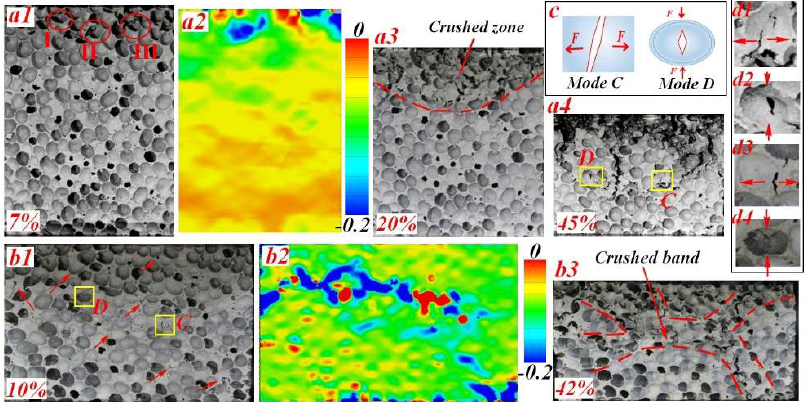
Figure 9. Typical deformation behavior of FG foam under ( a ) LC and ( b ) TC, ( c ) sketch of Mode C and Mode D and ( d ) typical deformation cells.